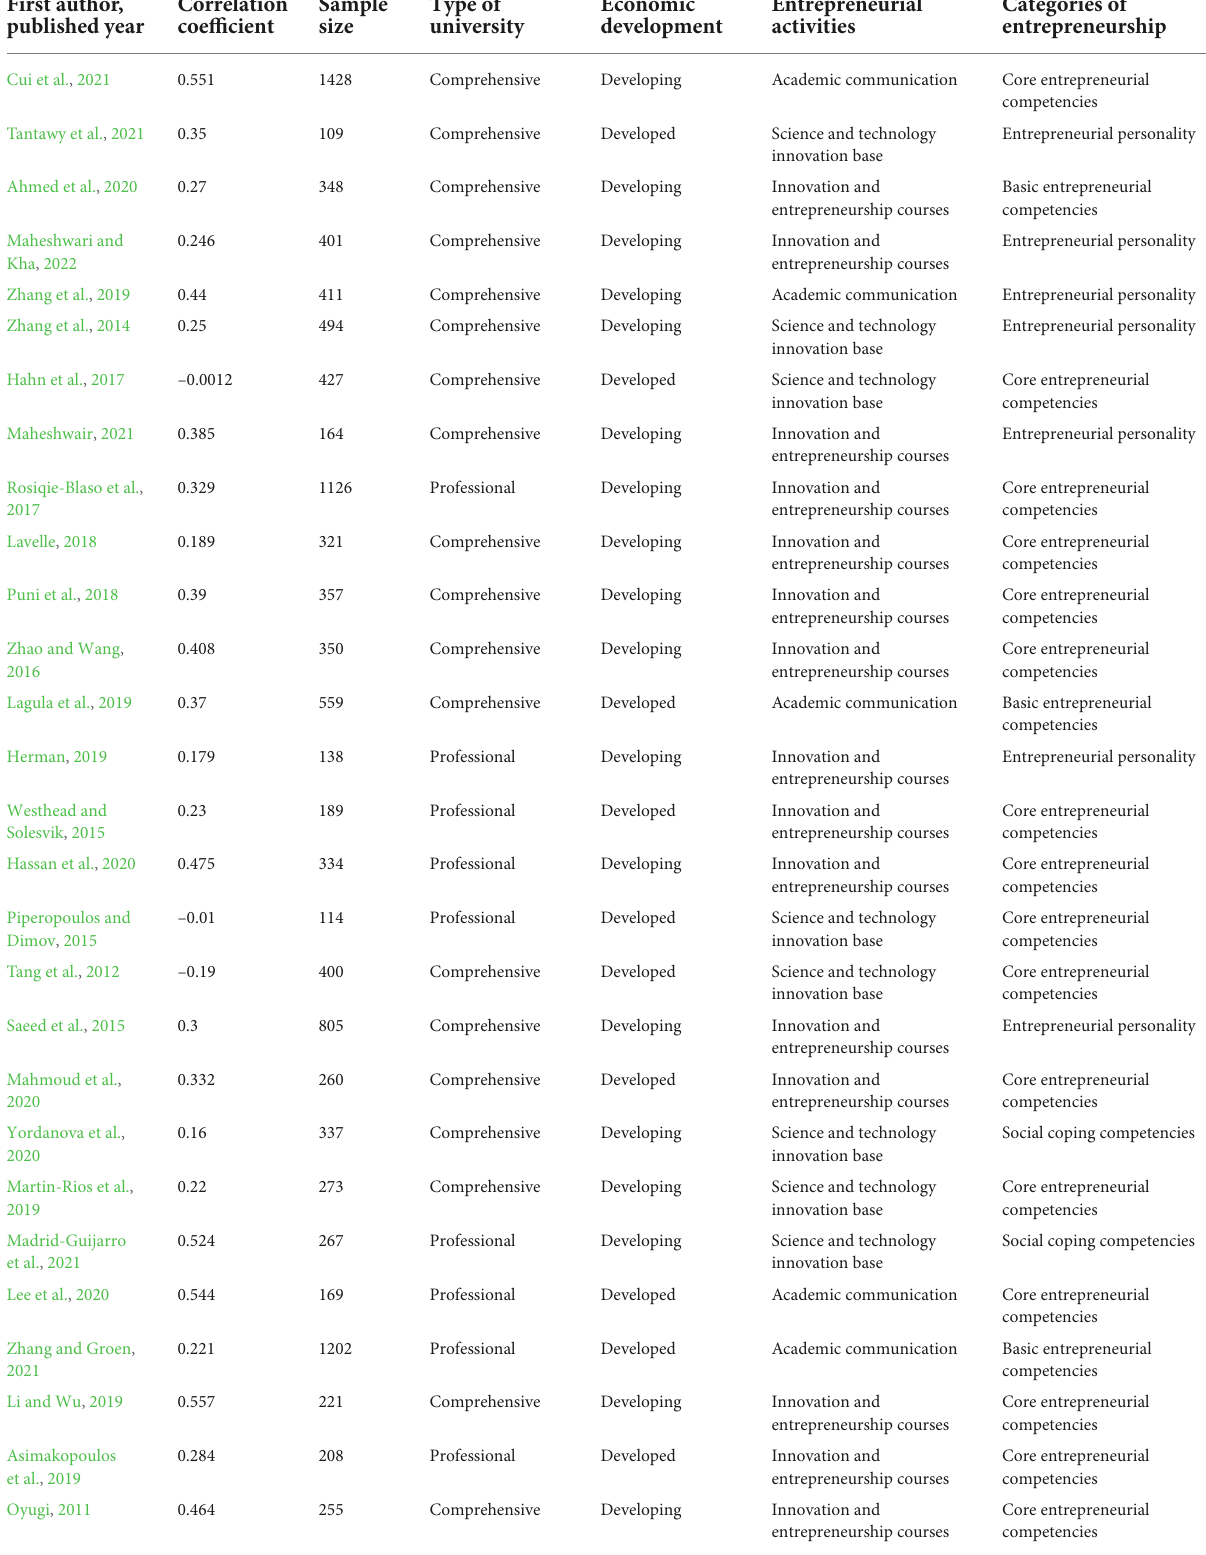
TABLE 1 Summary of basic information of the included